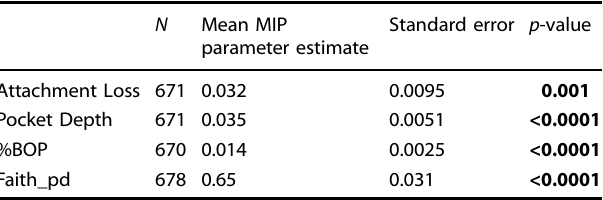
Table 3. Microbial indicator of periodontal disease (MIP) in subgingival plaque ( n = 787) is correlated with markers of cardiometabolic health.